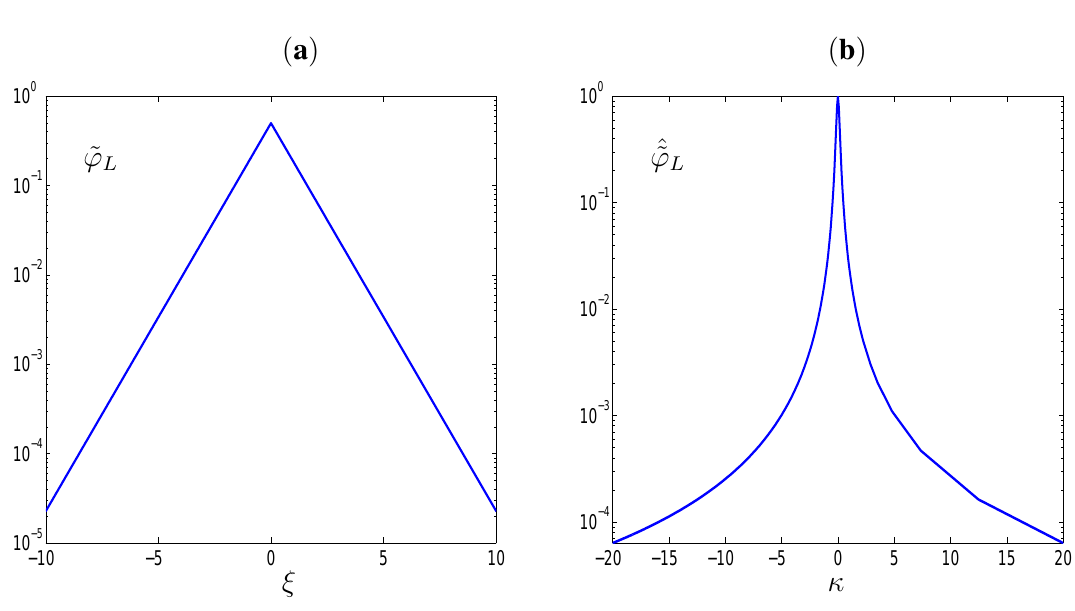
( a ) Exponential weight function ~ φ 1 ^~ φ = . The vertical axis is in L 1 + 4 π 2 κ 2